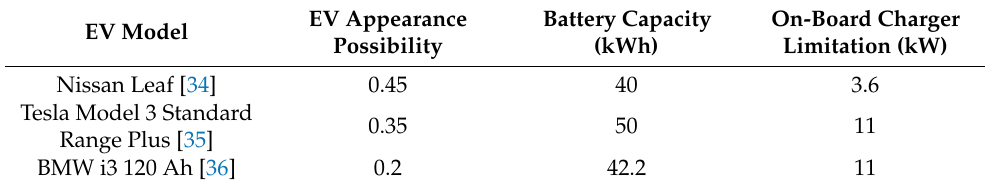
Table 1. EV model, appearance possibility in the PL, battery capacity and on-board charger limitation.